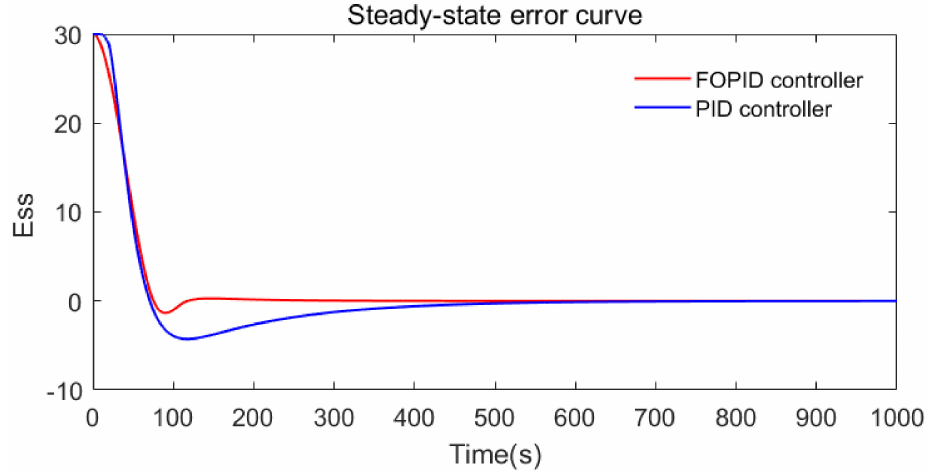
Figure 11. Steady state error curve with FO PI λ D µ controller and the PID